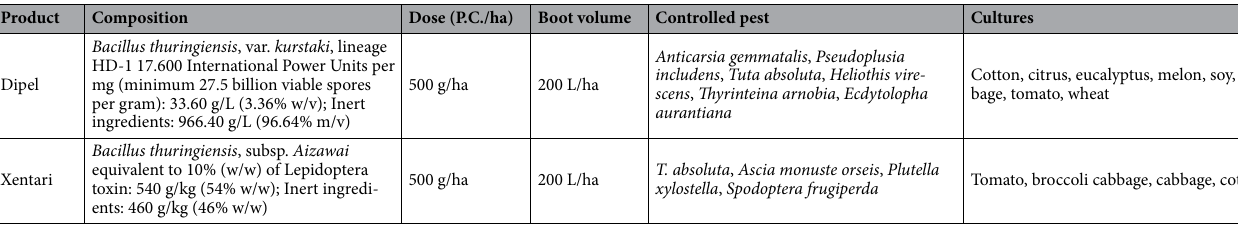
Table 3. Commercial products used, and the composition, dose, pests, and crops for which their use is recommended. Source : Agrofit 22 .